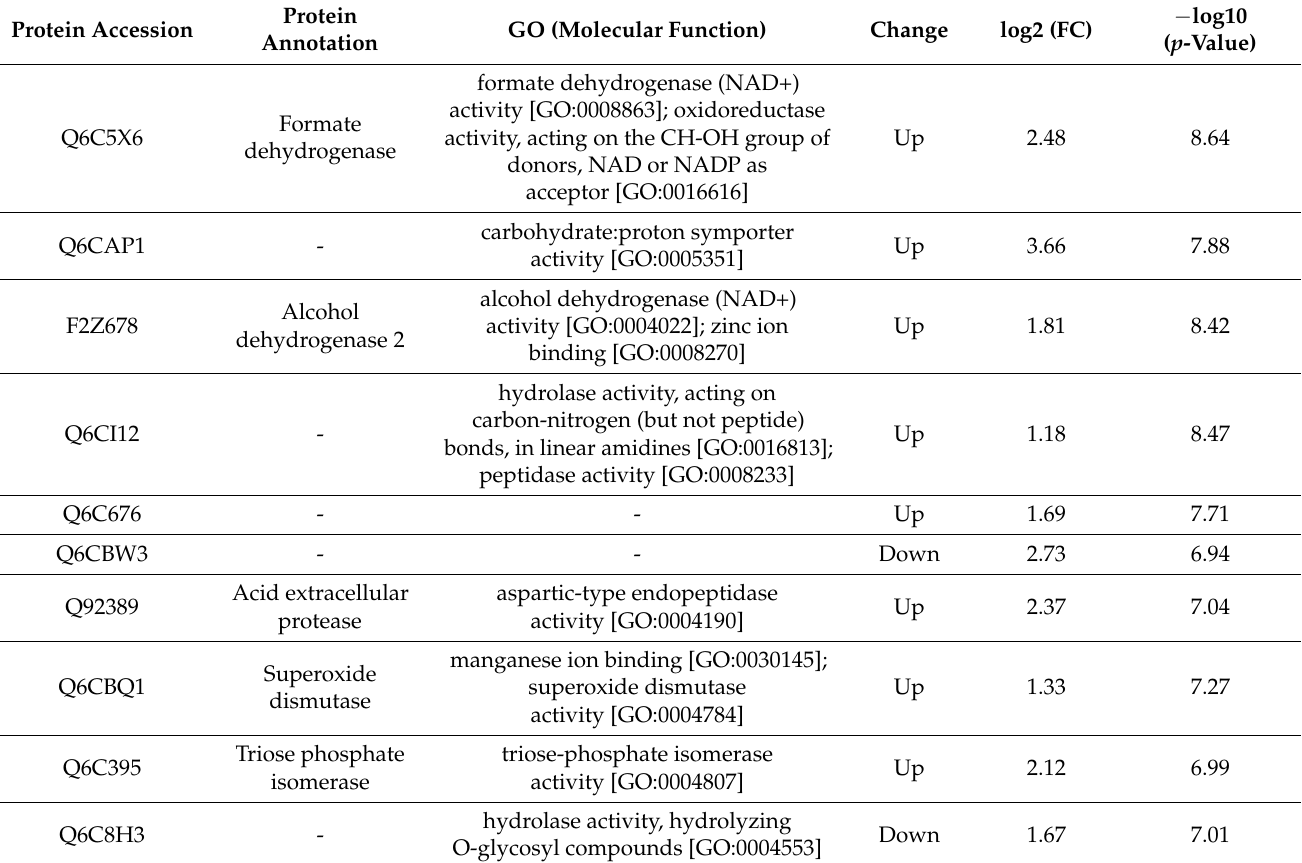
Table 2. Top 10 proteins with the largest differential expression upon maximized lipid